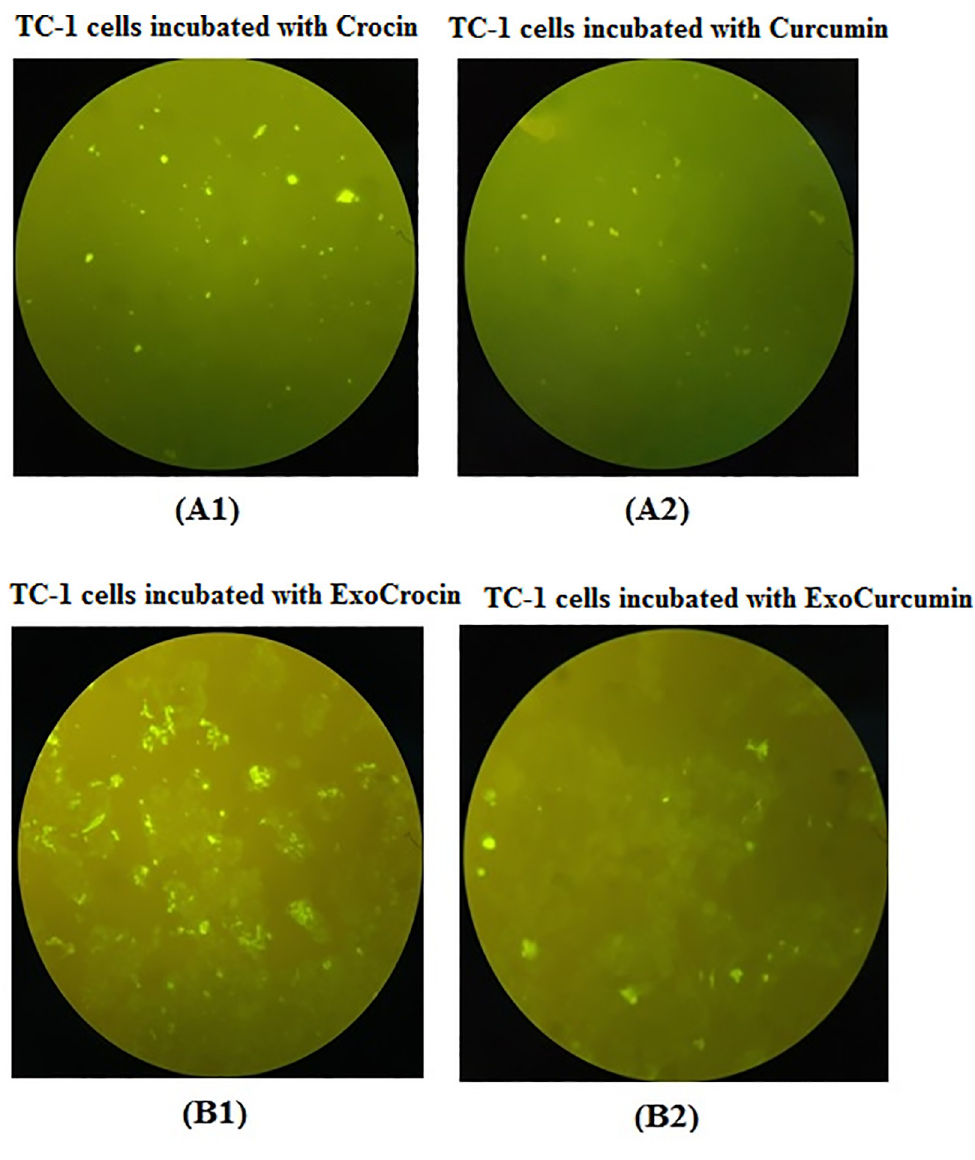
Fig 4. Delivery of exosomal crocin and curcumin forms in TC-1 cells using fluorescence microscopy: TC-1 cell line was incubated with crocin, curcumin (A1 & A2) and exosomal forms of these compounds (B1 & B2). (A1) TC-1 incubated with crocin, (A2) TC-1 incubated with curcumin, (B1) TC-1 incubated with ExoCrocin, and (B2) TC-1 incubated with ExoCurcumin. L1-E7 polypeptide + ExoCrocin (G2) and L1-E7 polypeptide + ExoCurcumin (G7) groups ( p > 0.05). The group immunized with L1-E7 polypeptide + ExoCrocin (G2) showed higher level of IL-4 than L1-E7 polypeptide (G1) and Exocrocin (G3; p < 0.05). However, the level of IL-4 secretion was significantly lower than IFN- γ in groups immunized with L1-E7 polypep- tide (G1), L1-E7 polypeptide + ExoCrocin (G2), L1-E7 polypeptide + ExoCurcumin (G7). The ratio of IFN- γ to IL-4 was increased about 10–11 folds in groups immunized with L1-E7 poly- peptide (G1), L1-E7 polypeptide + ExoCrocin (G2) and L1-E7 polypeptide + ExoCurcumin (G7) indicating direction of immune responses toward Th1 response. Moreover, ExoCrocin